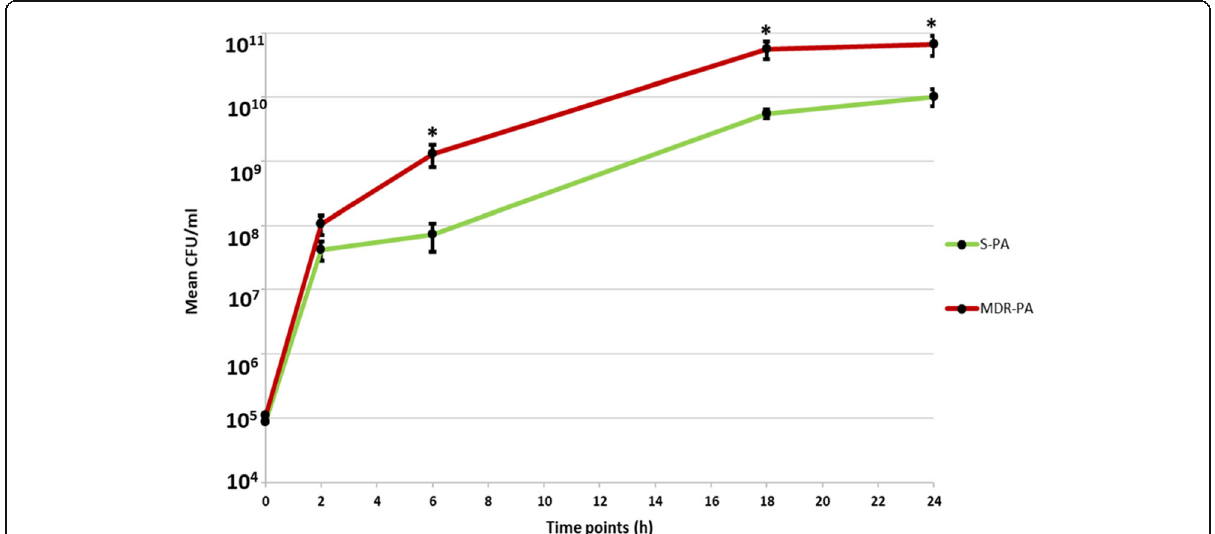
Fig. 1 Clinical isolates of P. aeruginosa were plated on MHA at indicated time points. Bacterial load and viability were enumerated by plate count method. Student ’ s test was used for the statistical analysis and data are represented as the mean colony forming units (CFU ± SD) from three sets of independent experiments. * p <